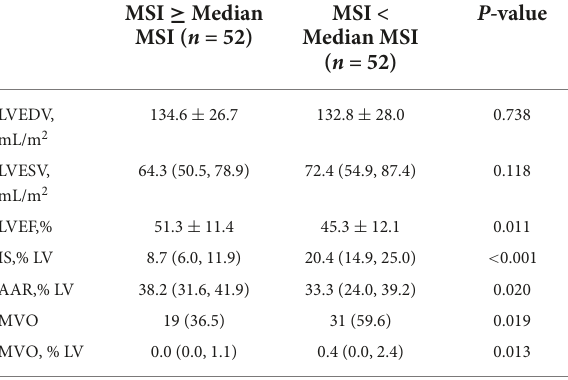
TABLE 2 Cardiovascular magnetic resonance results.